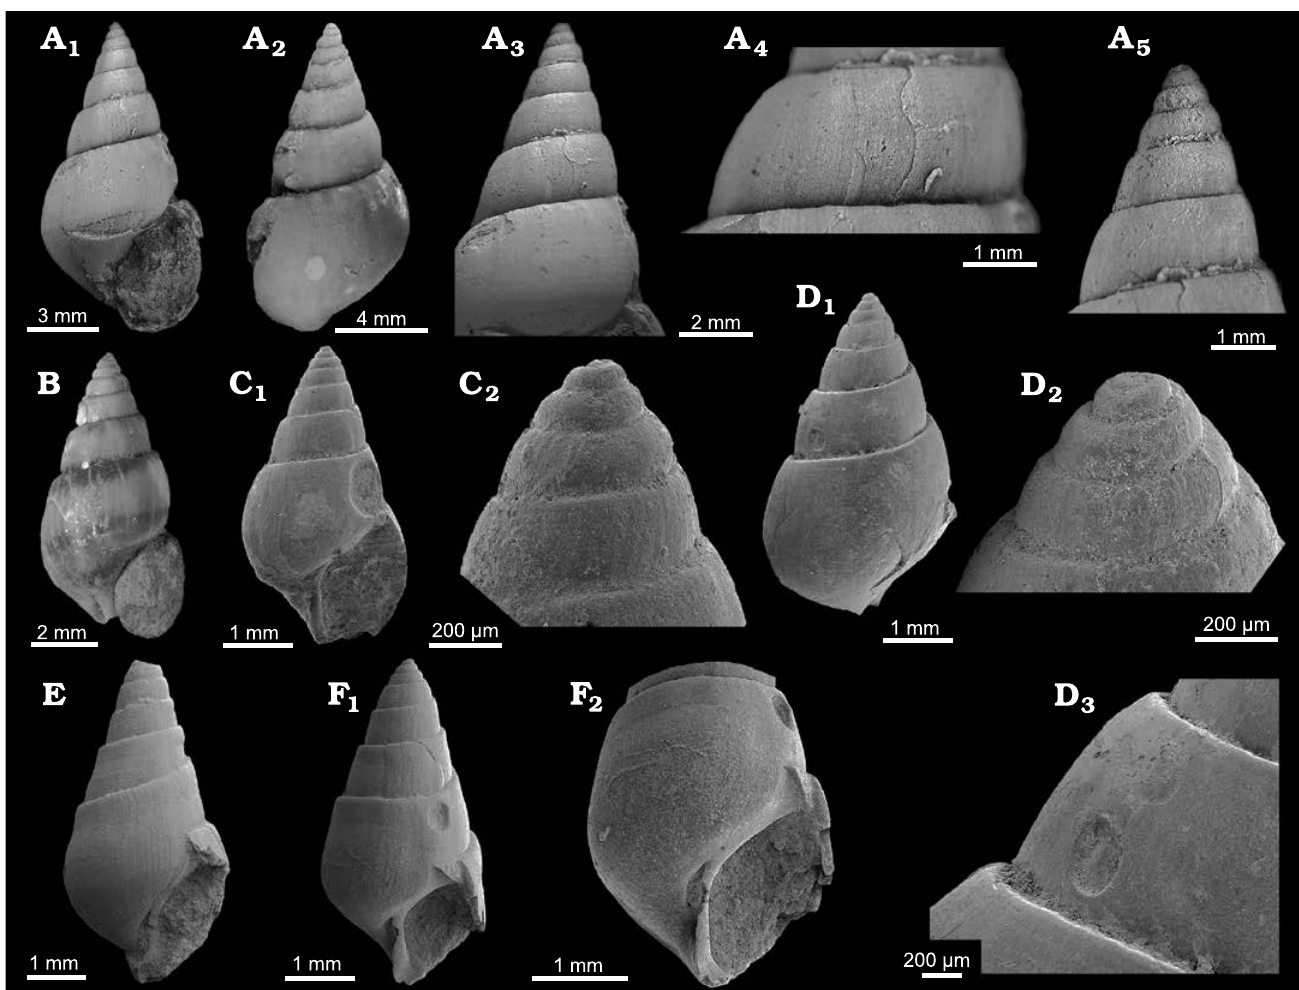
Fig. 10. Coelostylinid gastropod Coelostylina conica (Münster, 1841) from Lago Antorno (A–D) and Misurina Landslide (E, F), northern Italy, Cassian Formation, Carnian, Late Triassic. A . PZO 12803, in apertural (A 1 ) and abapertural (A 2 ) views; A 3 , spire whorls in lateral view; A 4 , close up of spire whorl showing faint spirally arranged micro-pits; A 5 , close up of apical whorls in lateral view. B . PZO 12804 in apertural view. C . PZO 12805, with drill hole, in apertural view (C 1 ); C 2 , early whorls including protoconch, in lateral view. D . PZO 12806, in lateral view (D 1 ); D 2 , early whorls including protoconch, in lateral view; D 3 , whorl detail with boring. E . PZO 12686, in apertural view. F . PZO 12687, with drill hole in apertural view (F 1 ); F 2 , detail, in apertural Lectotype : SNSB-BSPG AS VII 504, the specimen illustrated by Mün- ster (1841: pl. 23: 20).